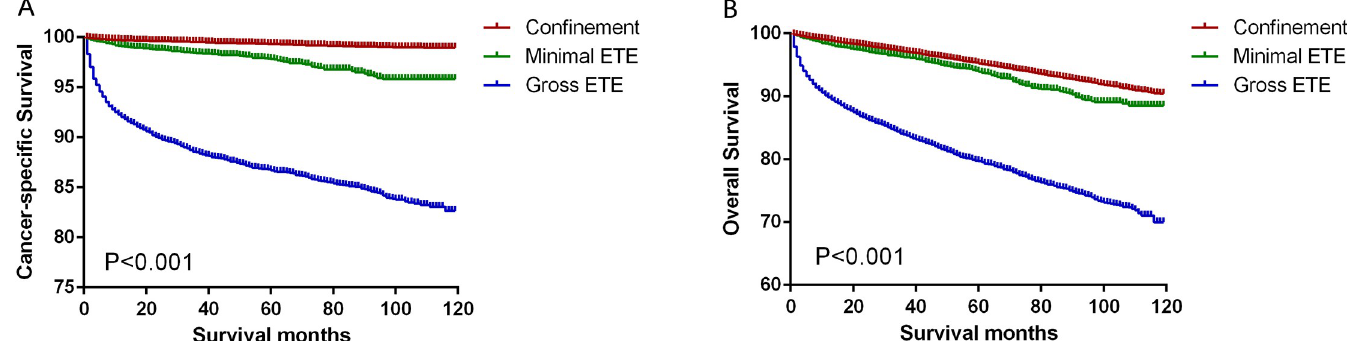
Fig 1. Kaplan-Meier curves for cancer-specific survival (A) and overall survival (B) among patients stratified according to subtype.